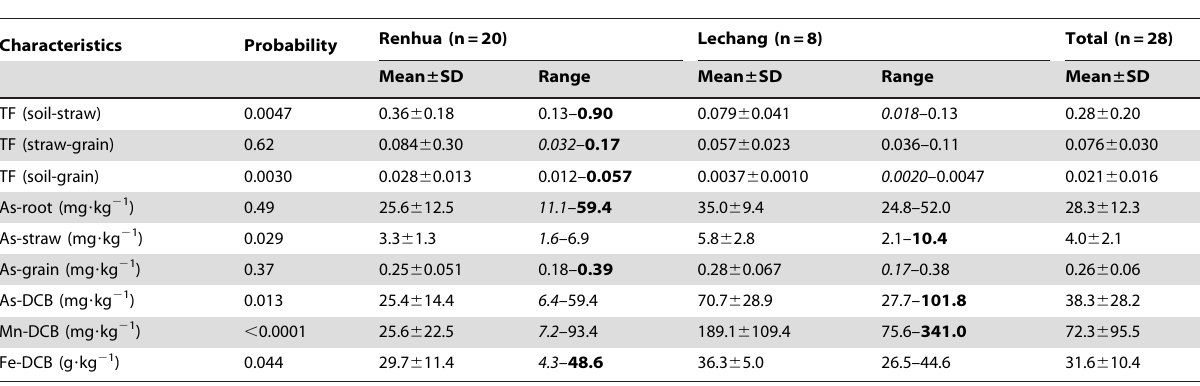
Table 2. Descriptive statistics of rice plant accumulation and transfer factors.